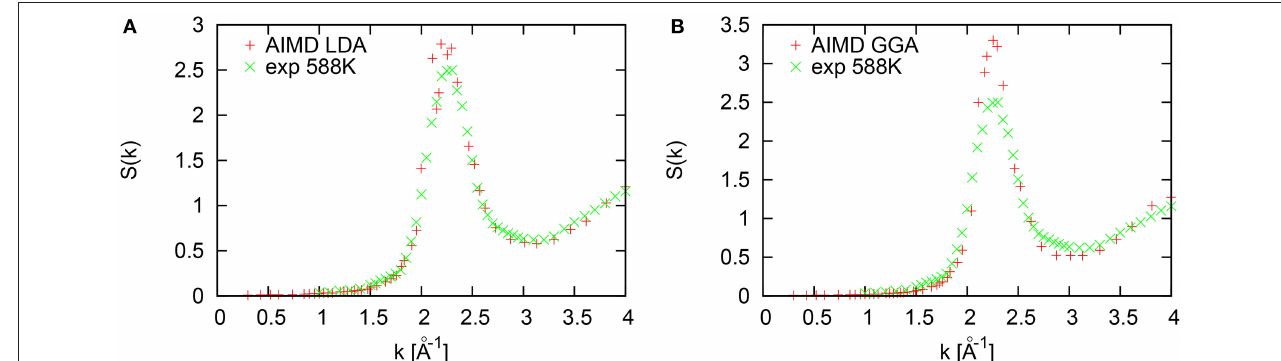
FIGURE 9 | Structure factor of liquid Tl at 577 K from simulations in LDA (A) and GGA (B) .